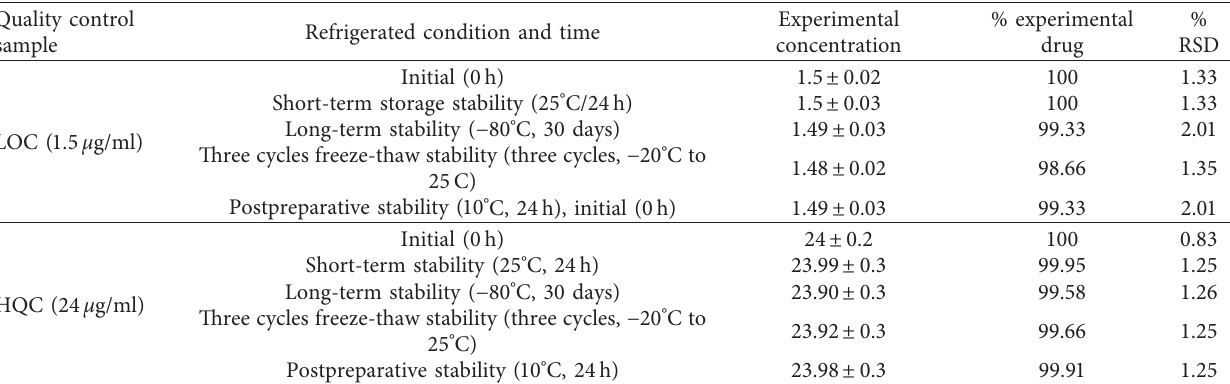
Table 6: Stability study of ATS at different quality